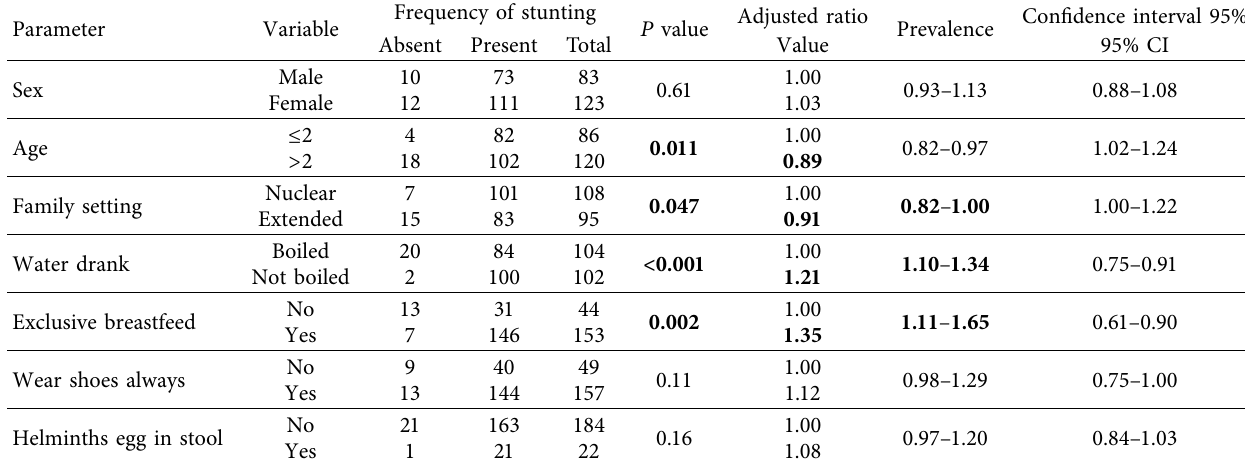
Table 3: Bivariate analysis of major sociodemographic and clinical factors associated with stunting among children attending selected health units in Bushenyi